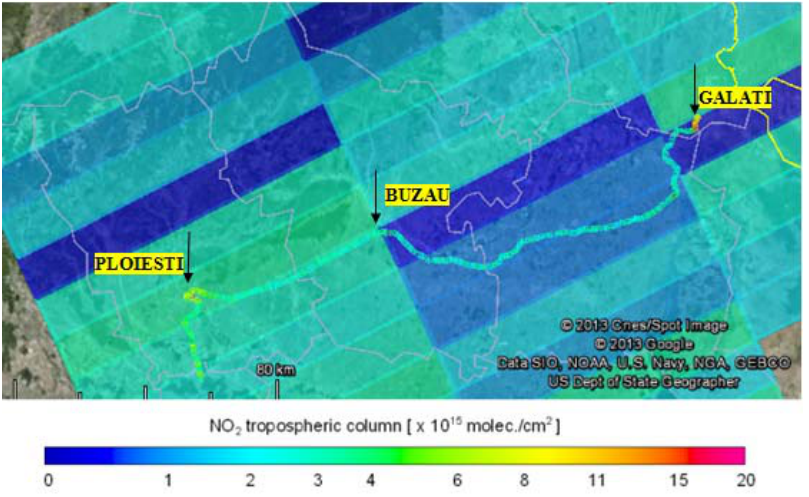
VCD for the Ploiesti - Galati road measurements 2 VCDs (rectangles) for the same 2